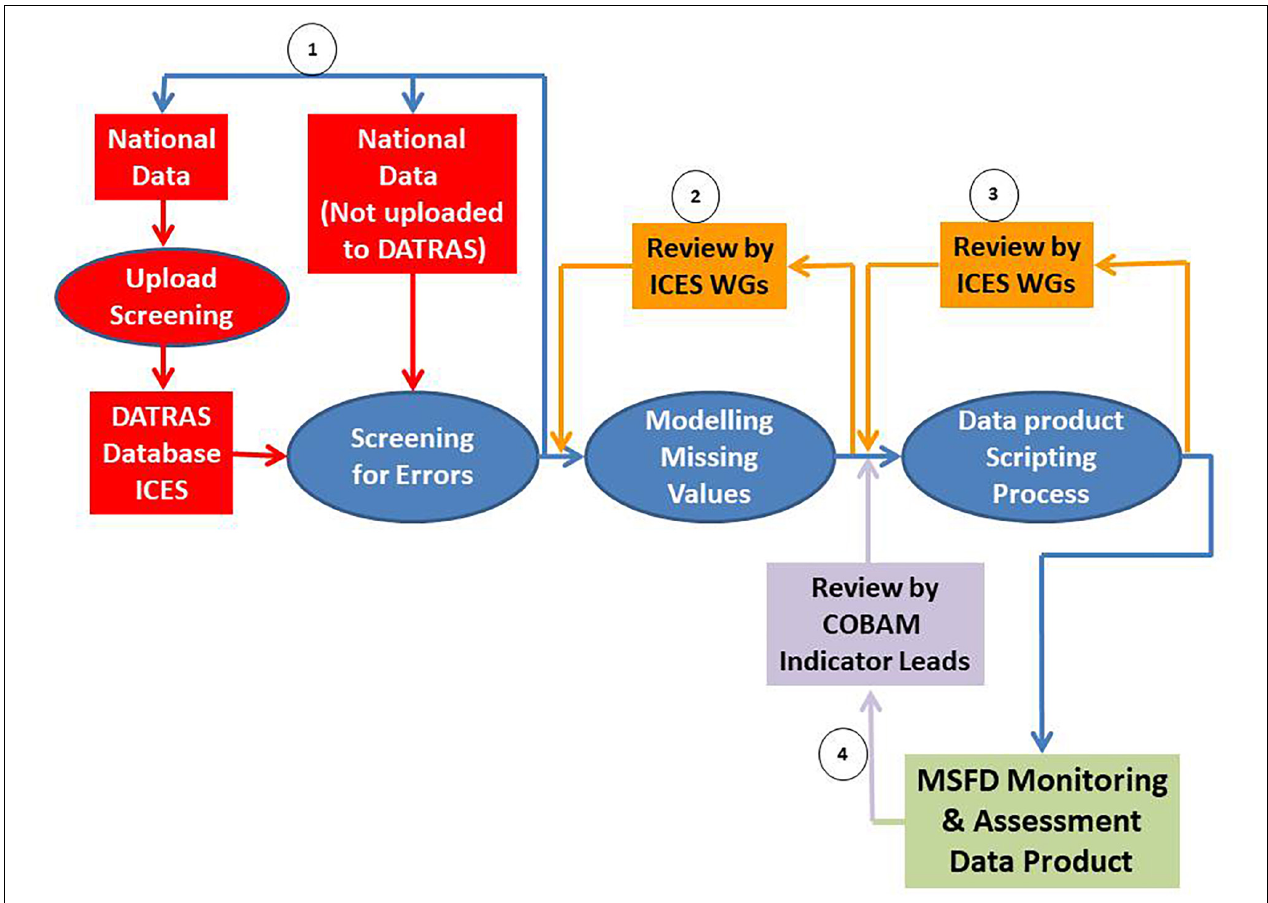
FIGURE 2 | Overview of the groundfish survey monitoring and assessment process relevant to the ICES community. Numbers highlight the different feedback loops following consultation with national data providers (1), ICES Working Groups (2 and 3) and indicator leads